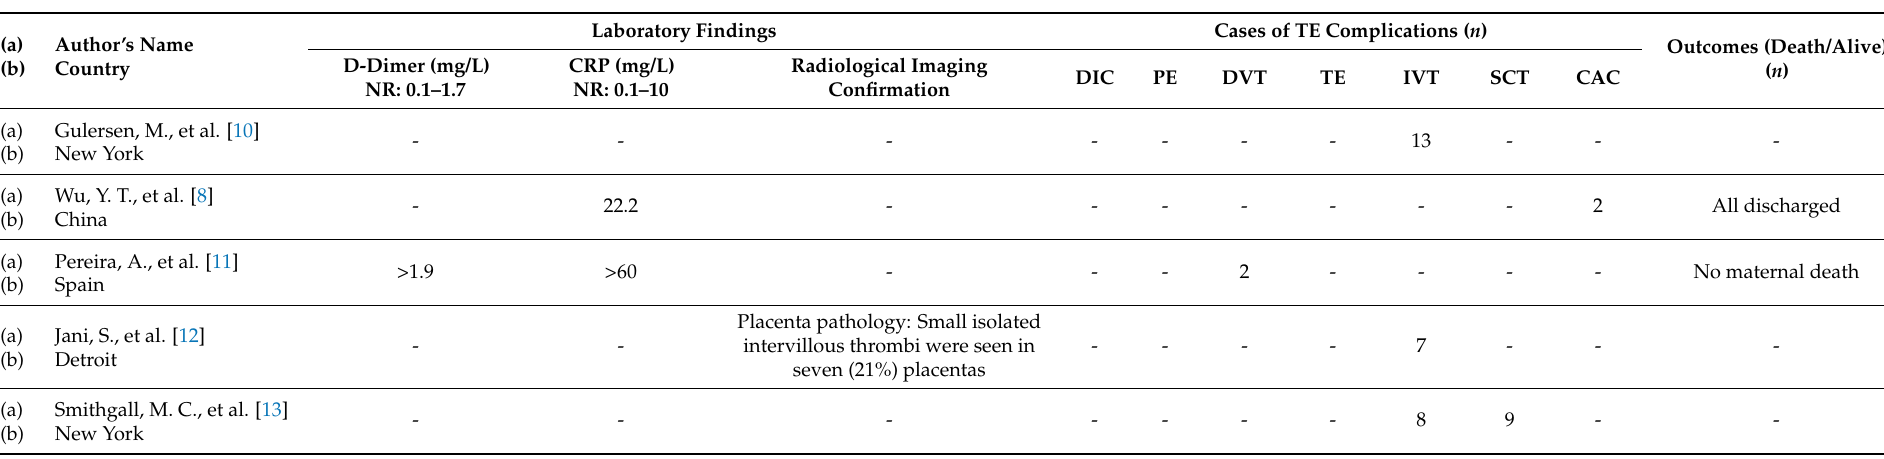
Table 4. Laboratory findings, Prevalence, and Outcomes of retrospective/prospective/cohort studies reporting thromboembolic (TE) complications among pregnant women infected with